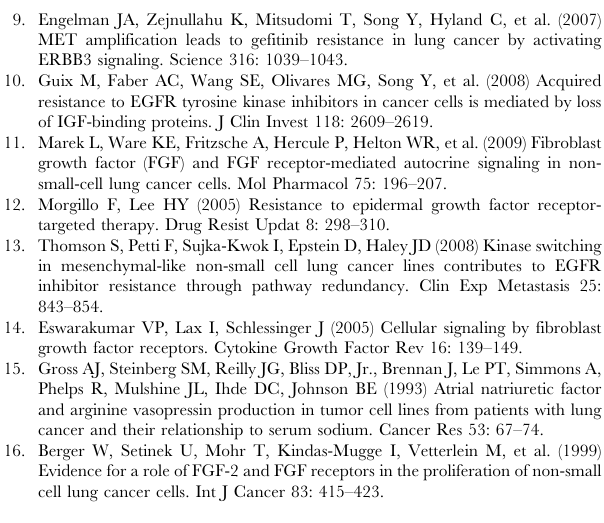
Figure S4 FGF2 rescues EGFR TKI dependent growth inhibition in HNSCC cells. UMSCC8 and HN31 head and neck